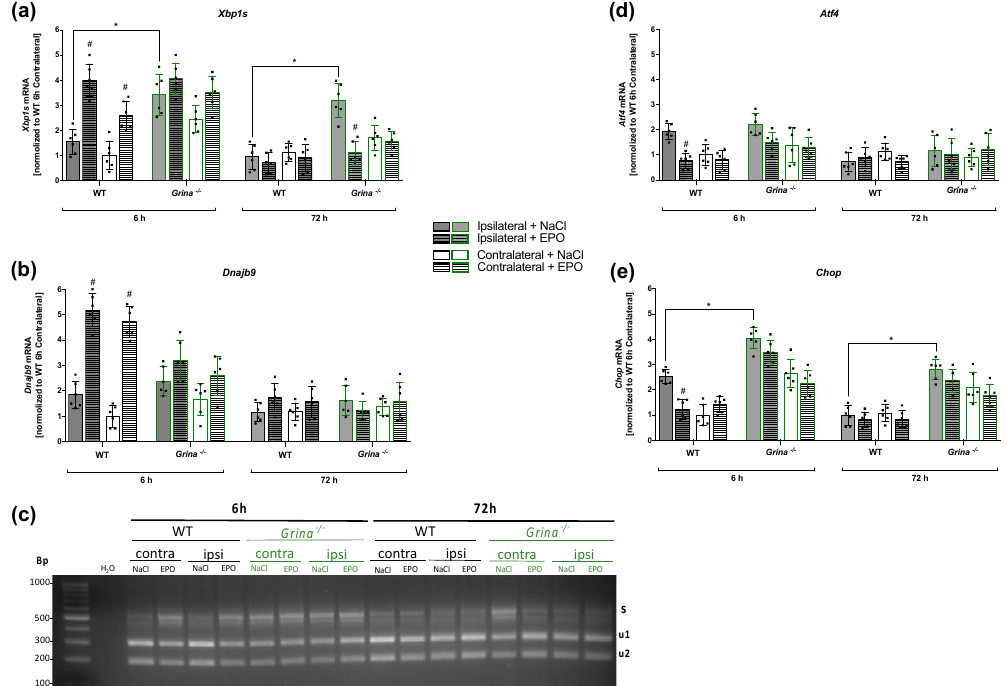
Figure 4. EPO enhances the activation of pro-survival IRE1 α and counteracts the pro-apoptotic PERK-branch of UPR in the early phase after ischemia / reperfusion injuryBiopsis of the peri-infarct zone and the coresponding contralateral hemiphere from EPO or saline treated Grina − / − mice and wildtype littermates after 30 min of tMCAo followed by 6 and 72 h of reperfusion were used for gene expression analyses ( n = 6). To evaluate the activation of the IRE1 α after stroke, mRNA levels of Xbp1s ( a ) and Dnajb9 ( b ) were measured using RT-qPCR. ( c ) The expression of spliced Xbp1s mRNA was evaluated by an Xbp1 splicing detection assay. cDNA was used to amplify Xbp1 by PCR. Xbp1 u amplicon digestion by PstI resulted in two fragments (u1, u2). Size of Xbp1s amplicon lacking PstI sites was 473bp. To monitor PERK activation, mRNA levels of Atf4 ( d ) and Chop ( e ) were measured using RT- qPCR. Bars represent means ± SD. n = 6 of all genotypes and treatment groups. * p < 0.05 intergroup comparison, # p < 0.05 EPO treatment compared to the vehicle group.